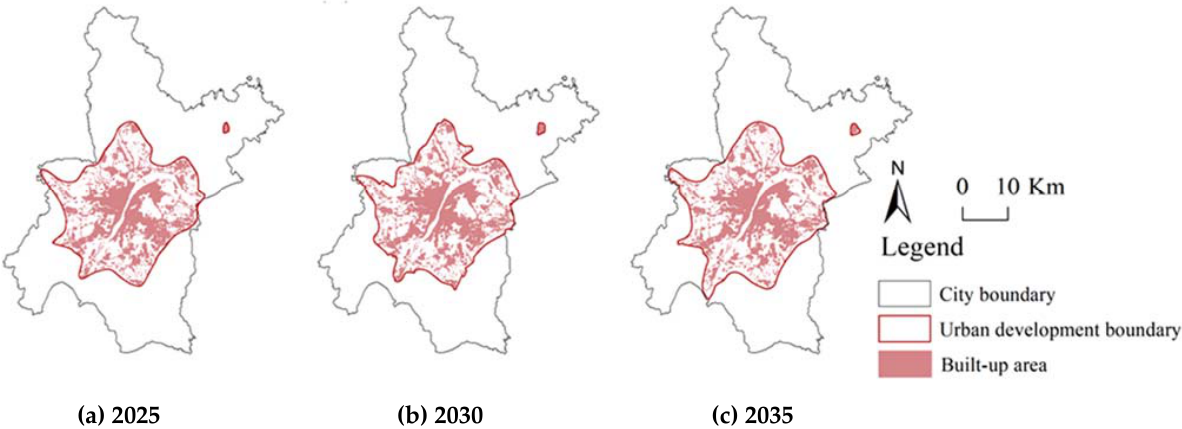
Figure 10. Urban development boundary for ( a ) 2025, ( b ) 2030, and ( c ) 2035 simulated by the CA-Markov model.